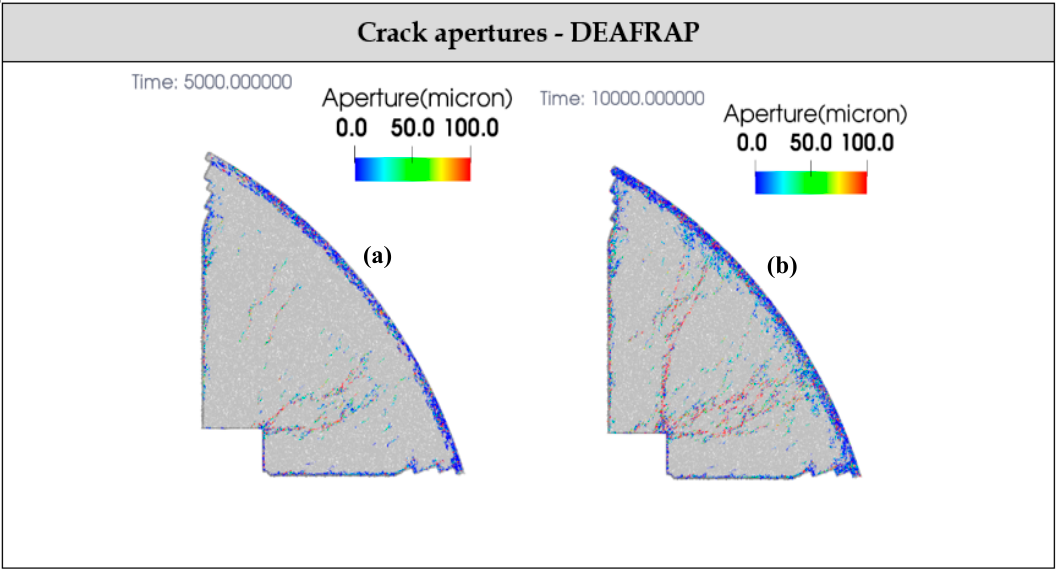
Figure 13. Distributions of crack apertures obtained with DEAFRAP with a maximum plotted aperture of 0.1 mm at 5000 years ( a ) and 10,000 years ( b ). Cracks with apertures larger than 0.1 mm appear to penetrate the backfill by 10,000